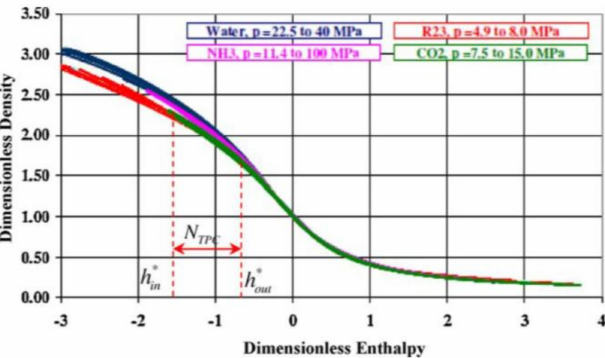
Figure 4. Trend of the dimensionless density vs. dimensionless enthalpy for four different fluids (adapted from reference [37] with the editor’s